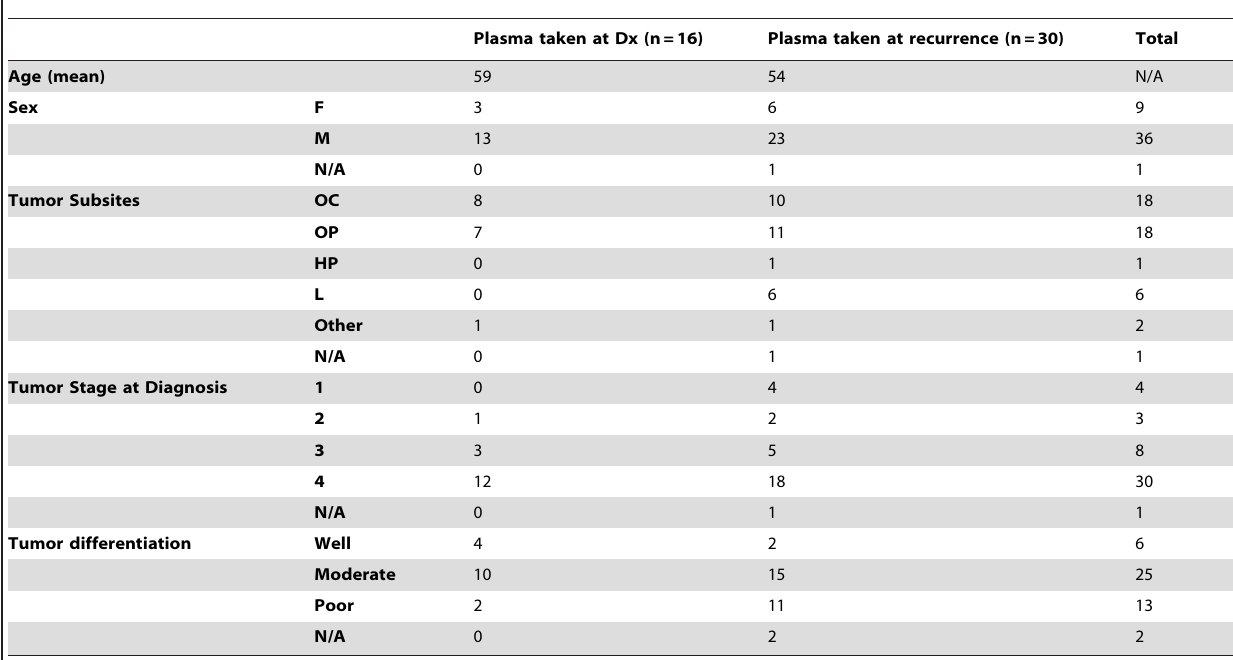
Table 3. Plasma characteristics from patients with head and neck squamous cell carcinoma.